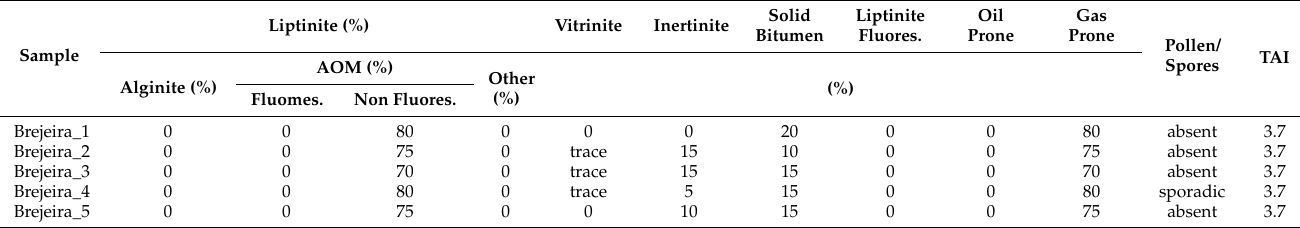
Table 2. Results of organic petrography from 5 samples (Brejeira 1, 2, 3, 4, and 5), analyzed by Weatherford Laboratories. Sample